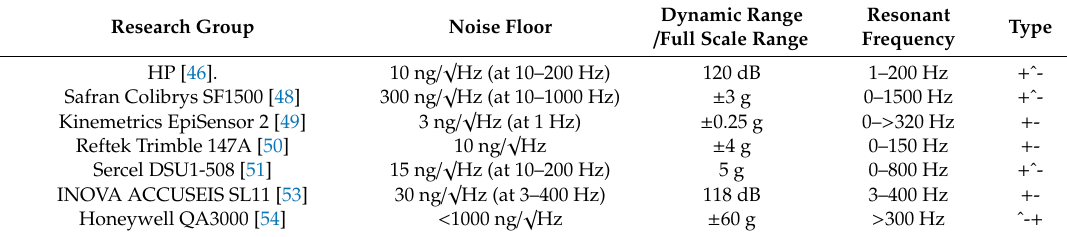
√ Hz noise floor but a potential